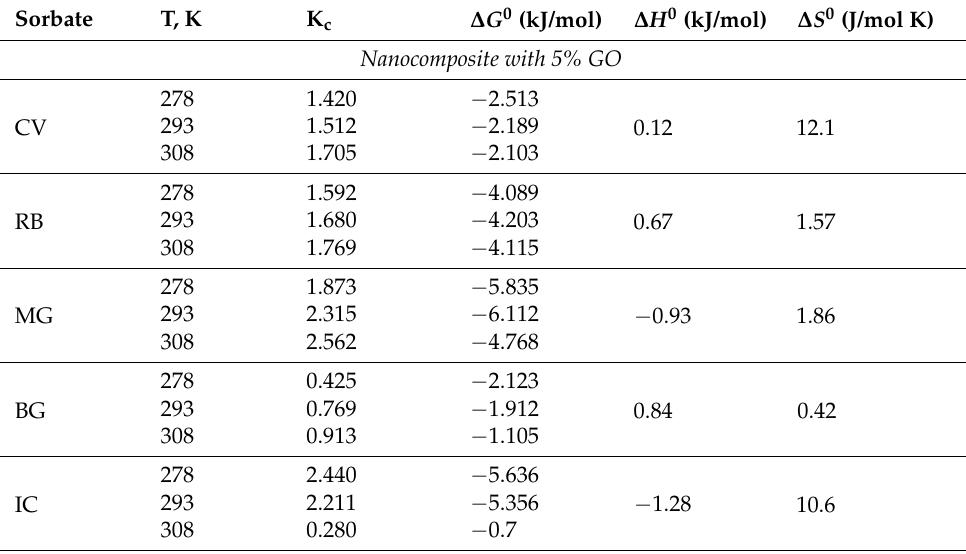
Table 5. Thermodynamic parameters of dye adsorption by the